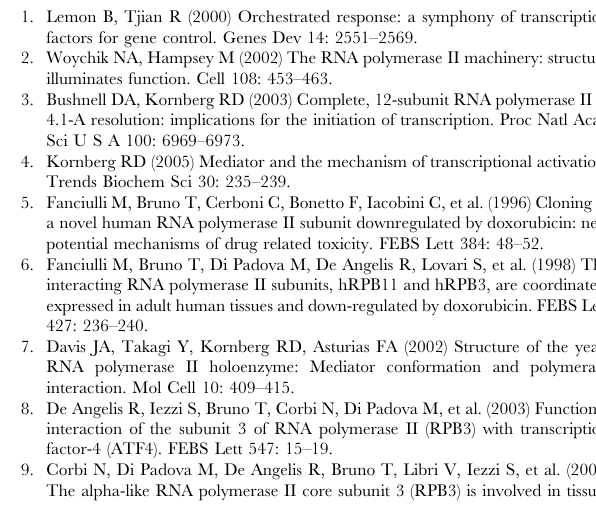
Figure S1 A: eEF1 c binds the Vimentin promoter at the endogenous chromosomal site. Chromatin immuno-precipitation was performed in human neuroblastoma SY5Y cell line using